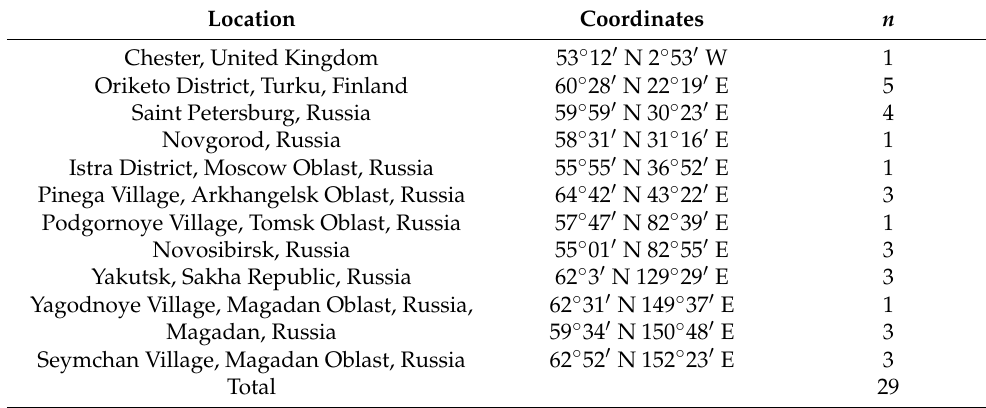
Table 1. Geographical localities of the Aglais urticae capture, their coordinates, and the number of individuals